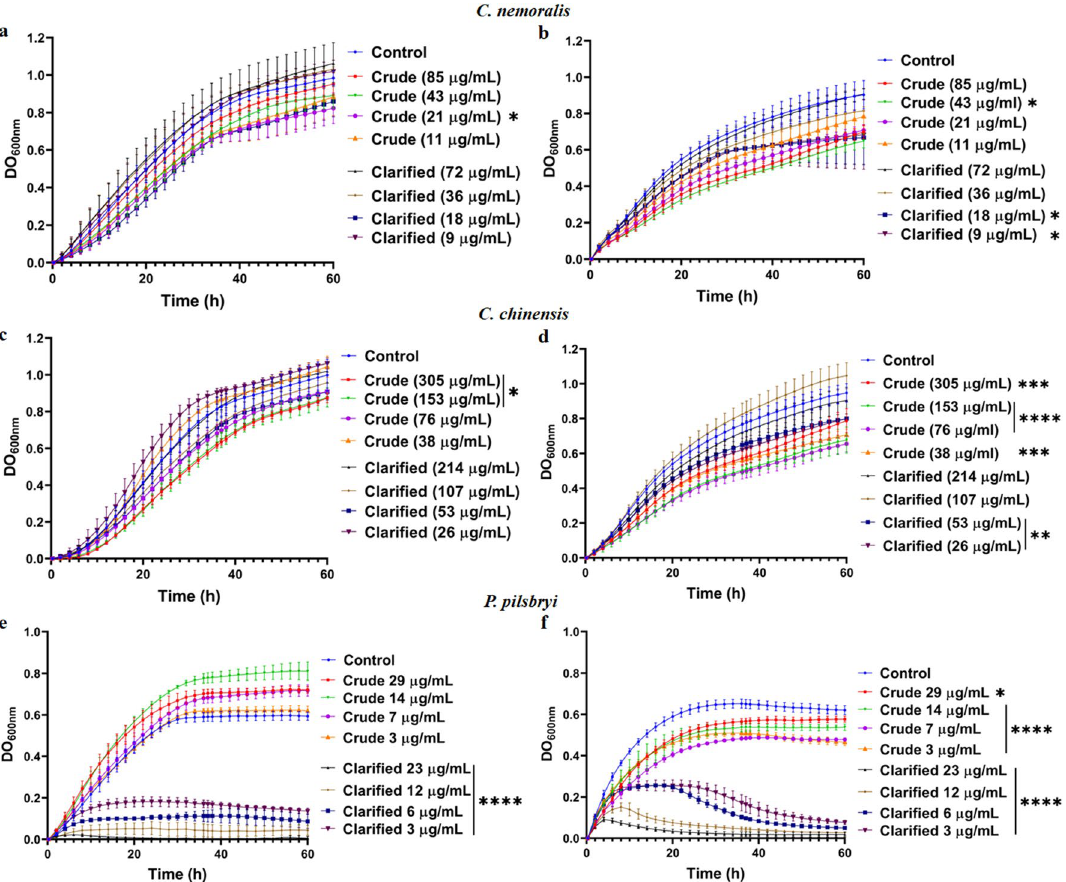
Figure 1. Effect of extracts from mollusks towards C. neoformans growth. ( a ) and ( b ) Effect of extracts from C. nemoralis at 30 °C and 37 °C, respectively; ( c ) and ( d ) Effect of extracts from C. chinensis at 30 °C and 37 °C, respectively; and ( e ) and ( f ) Effect of extracts from P. pilsbryi at 30 °C and 37 °C, respectively. Controls consist of C. neoformans cells in YNB media without extracts. Experiments performed in five biological replicates and technical duplicate. Error bars indicate standard deviation. Statistical analysis performed using a one-way ANOVA and a Dunnett’s multiple comparison test with a p-value of 0.05; *p < 0.05; **p < 0.01; ***p < 0.001 and ****p < 0.0001. Figures created using GraphPad Prism